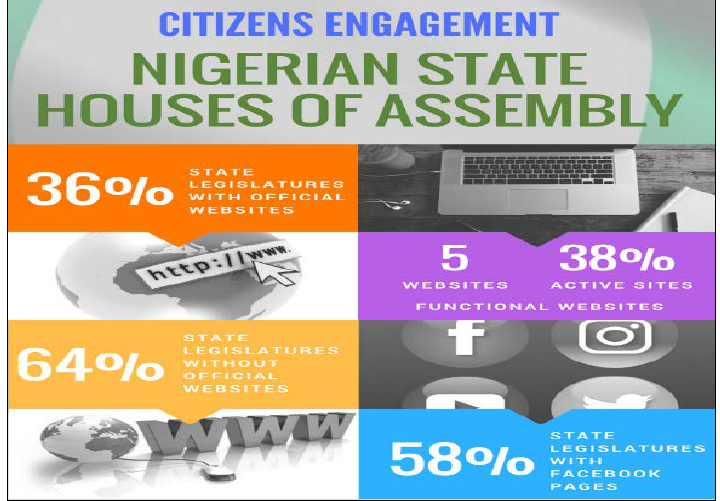
Figure 7: Nigerian State Houses of Assembly